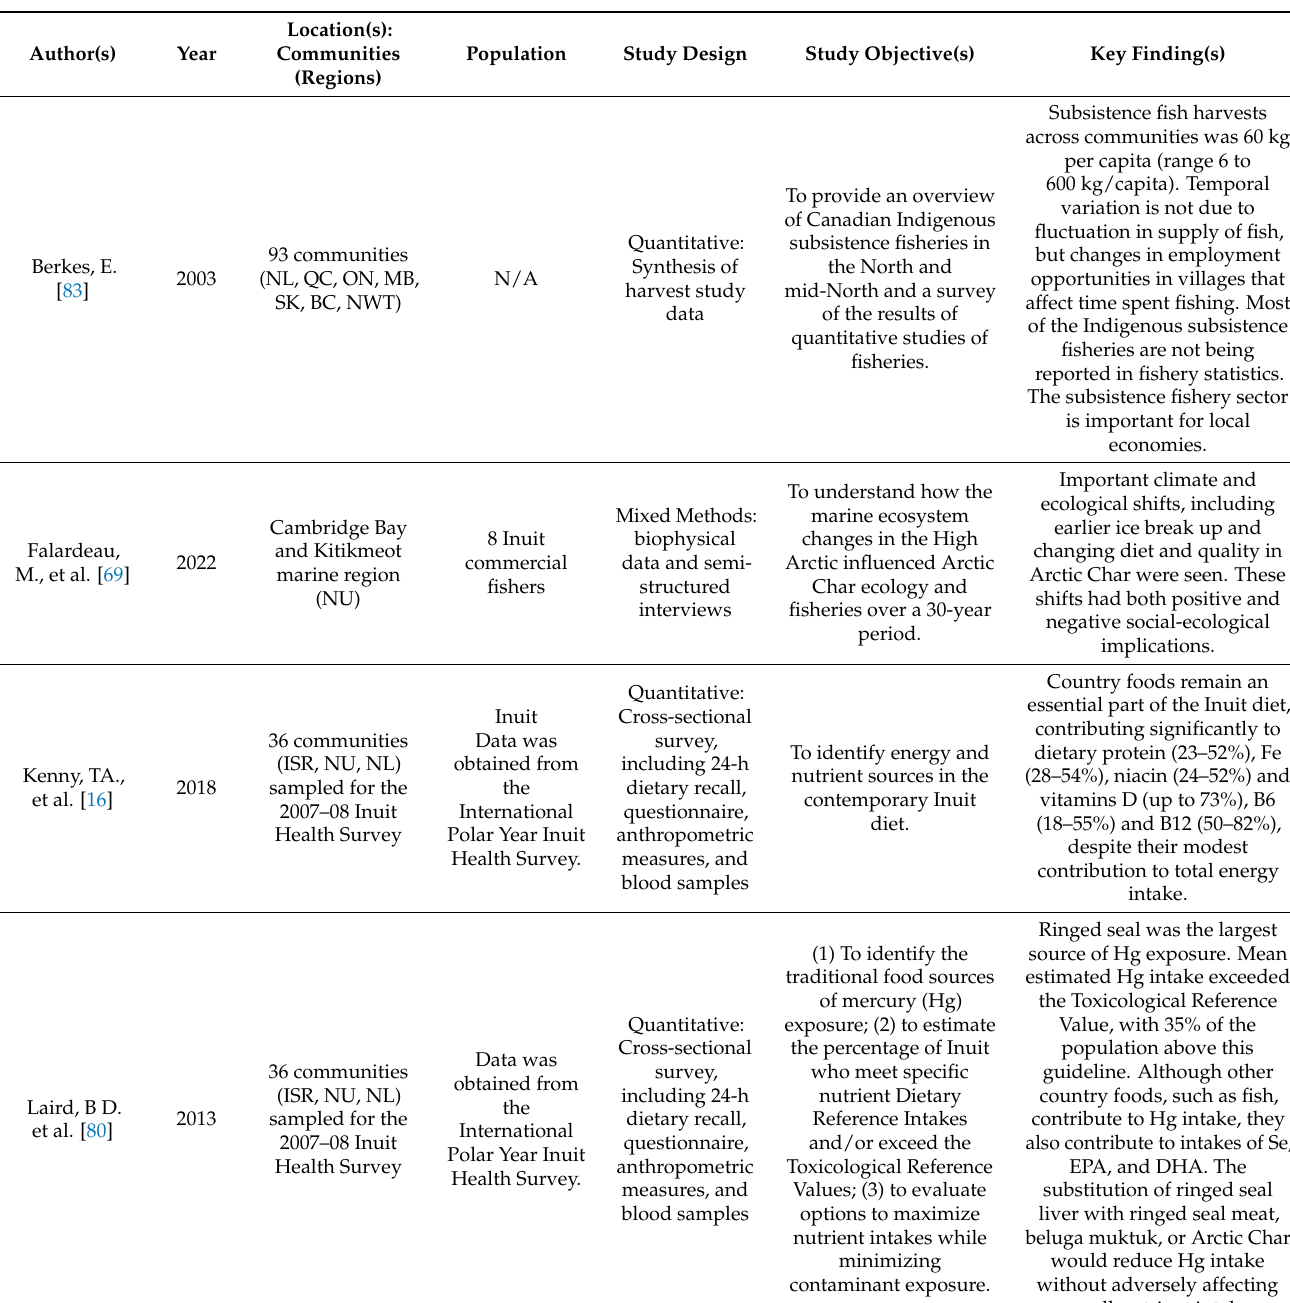
Table A3. Study Characteristics of the 31 articles ncluded in this review examining the role of the fish, seafood, and fisheries in food security in Inuit Nunangat. Articles were ordered by region (Nunavik, Nunavut, ISR, and Nunatsiavut, or multiple regions in Inuit Nunangat for studies covering more than one region) and